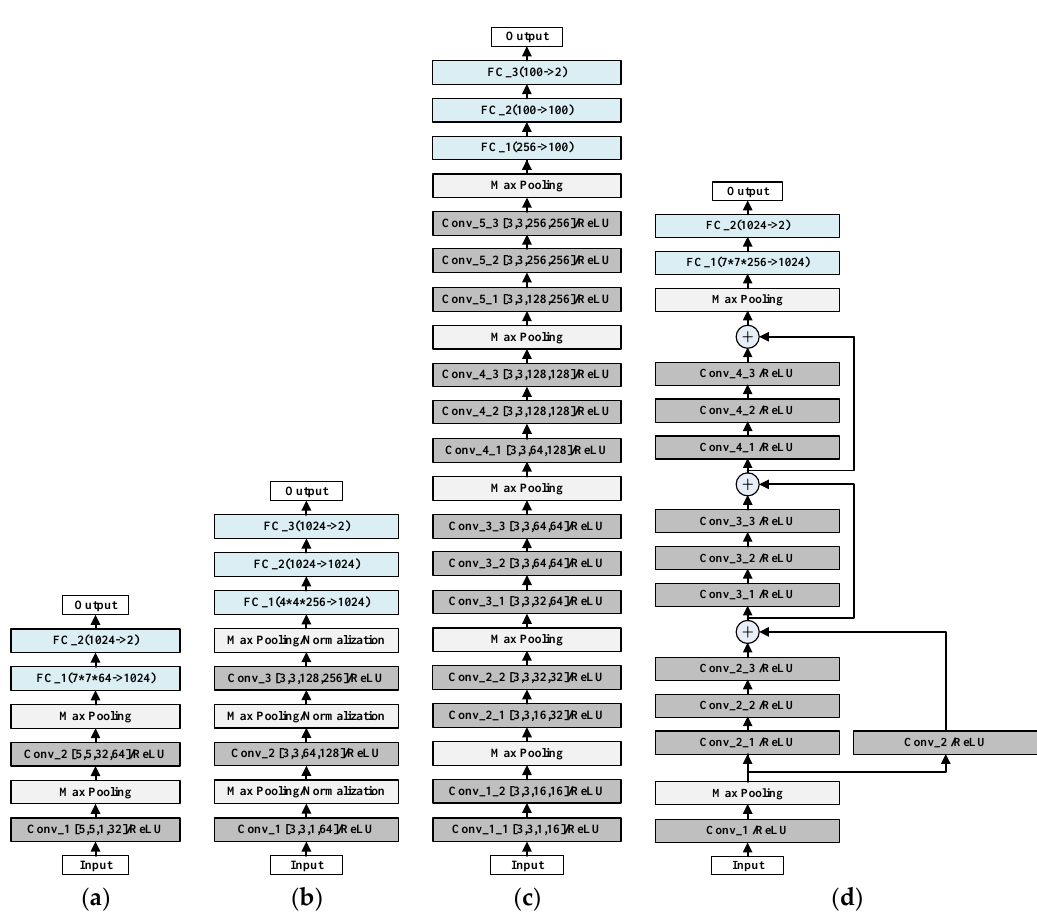
Figure 7. Structure of four CNNs: ( a ) architecture of LeNet; ( b ) architecture of AlexNet; ( c ) architecture of VGGNet; ( d ) architecture of ResNet.